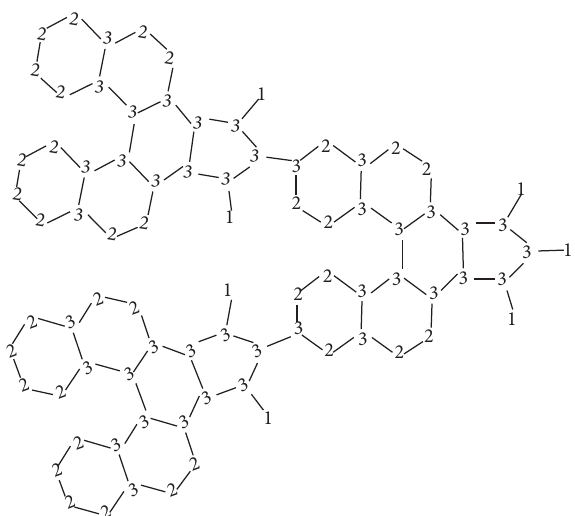
Figure 11: D [ 2 ] along with the degree of each vertex. 2